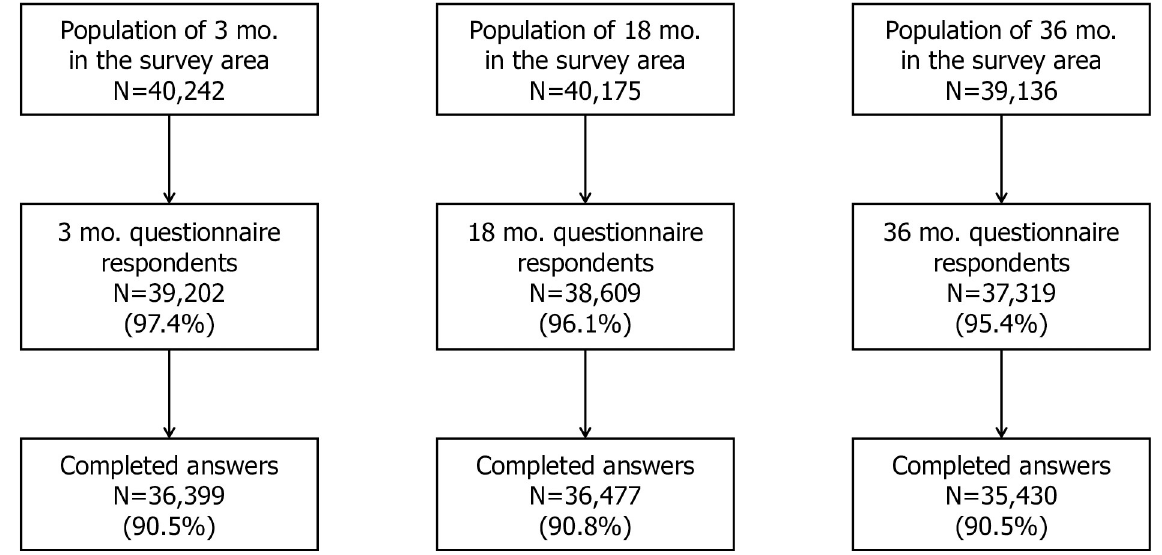
Fig 1. Population in the survey area and response rates of questionnaire in three age groups. (mo = months old).